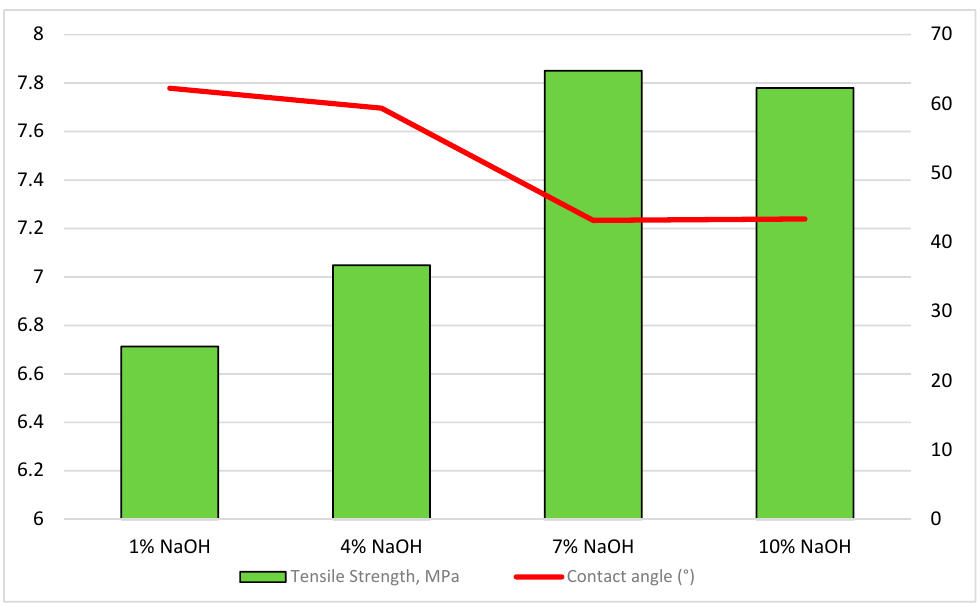
Figure 16. Effect of rubber contact angle on tensile strengths. Figure 16. E ff ect of rubber contact angle on tensile